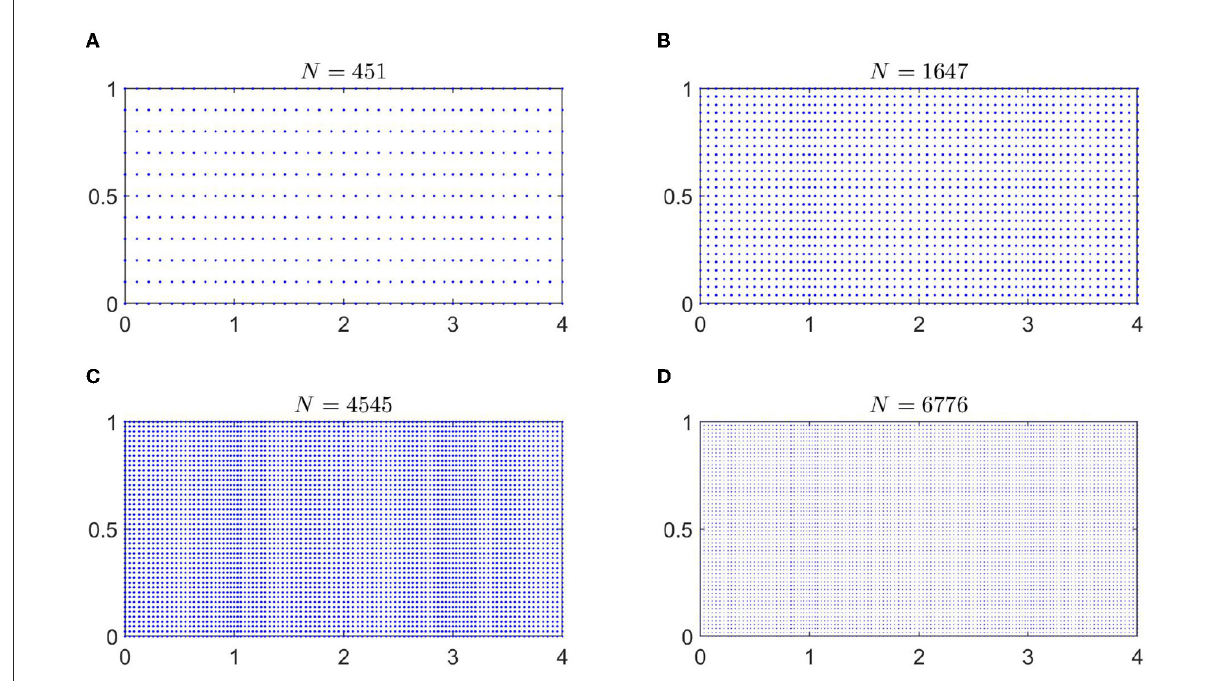
FIGURE13 Clouds of nodes for the Elder problem, using different number of total nodes. (A) N = 41 × 11 = 451, (B) N = 61 × 27 = 1,647, (C) N = 101 × 45 = 4,545, and (D) N = 121 × 56 =